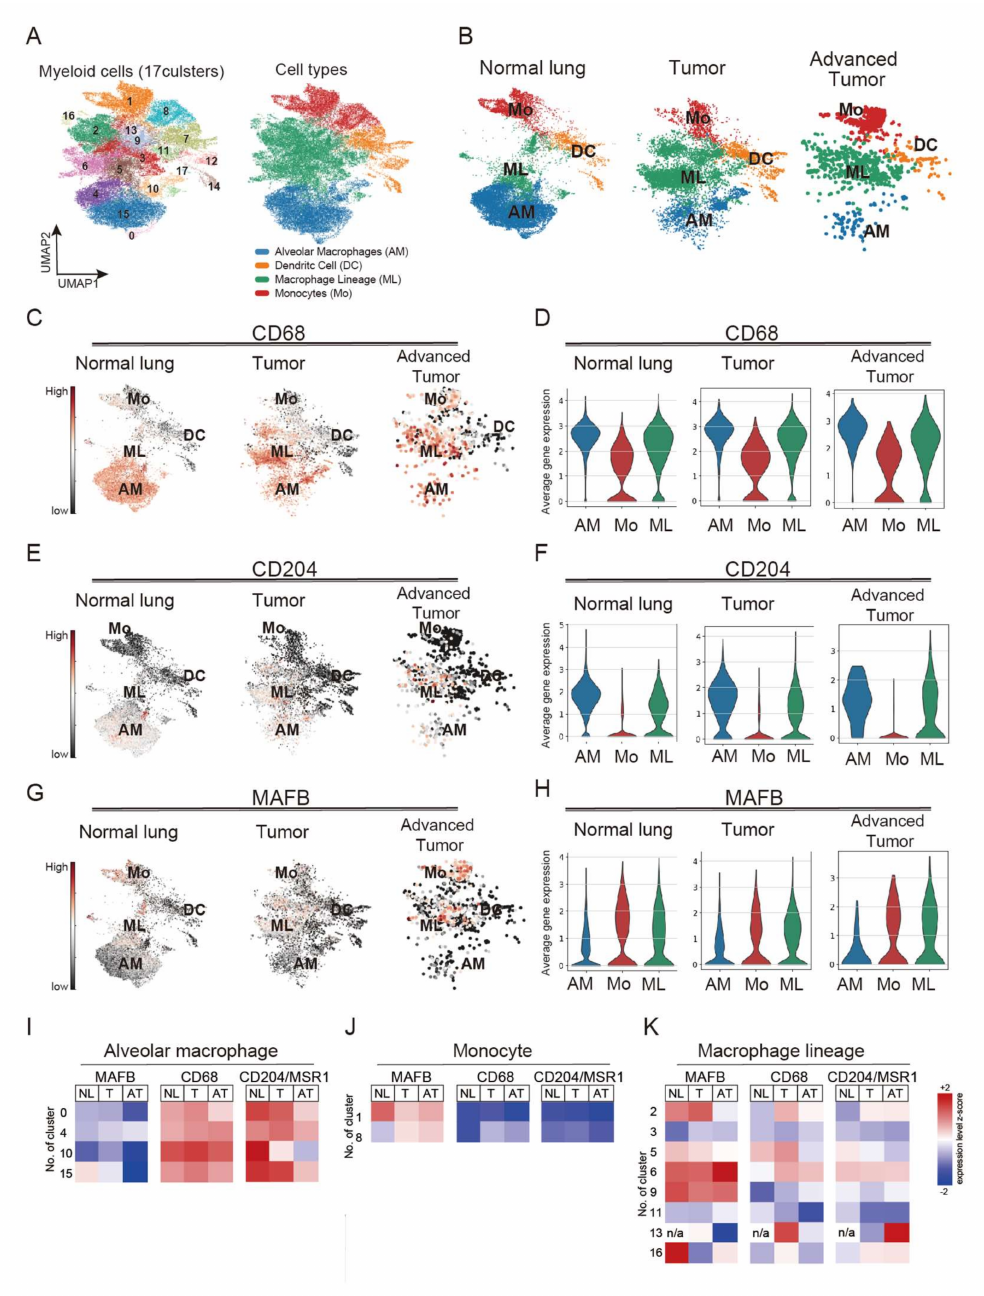
Figure 1. Single-cell RNA sequencing (scRNA-seq) analysis obtained from 44 patients with treatment- naive lung adenocarcinoma. Single-cell RNA raw data included normal lung tissue ( n = 11), tumor tissue (stage I and III, n = 7), and advanced tumor tissue (stage IV, n = 4). Raw data were downloaded and processed using sctransform function in Seurat (v3). ( A ) Identified 17 clusters of the myeloid population. ( B ) monocytes (Mo), alveolar macrophages (AM), macrophages lineage (ML), and dendritic cells (DC) cluster distribution in normal lung tissues, tumors, and advanced tumors. ( C , D ) CD68 expression pattern in normal lung tissues, tumor, and advanced tumor. ( E , F ) CD204 expression pattern in normal lung tissues, tumor, and advanced tumor. ( G , H ) MAFB expression pattern in normal lung tissues, tumor, and advanced tumor. ( I ) Heatmap analysis of the expression of MAFB, CD68, and CD204 in AM. ( J ) Heatmap analysis of the expression of MAFB, CD68, and CD204 in monocytes. ( K ) Heatmap analysis of the expression of MAFB, CD68, and CD204 in macrophage